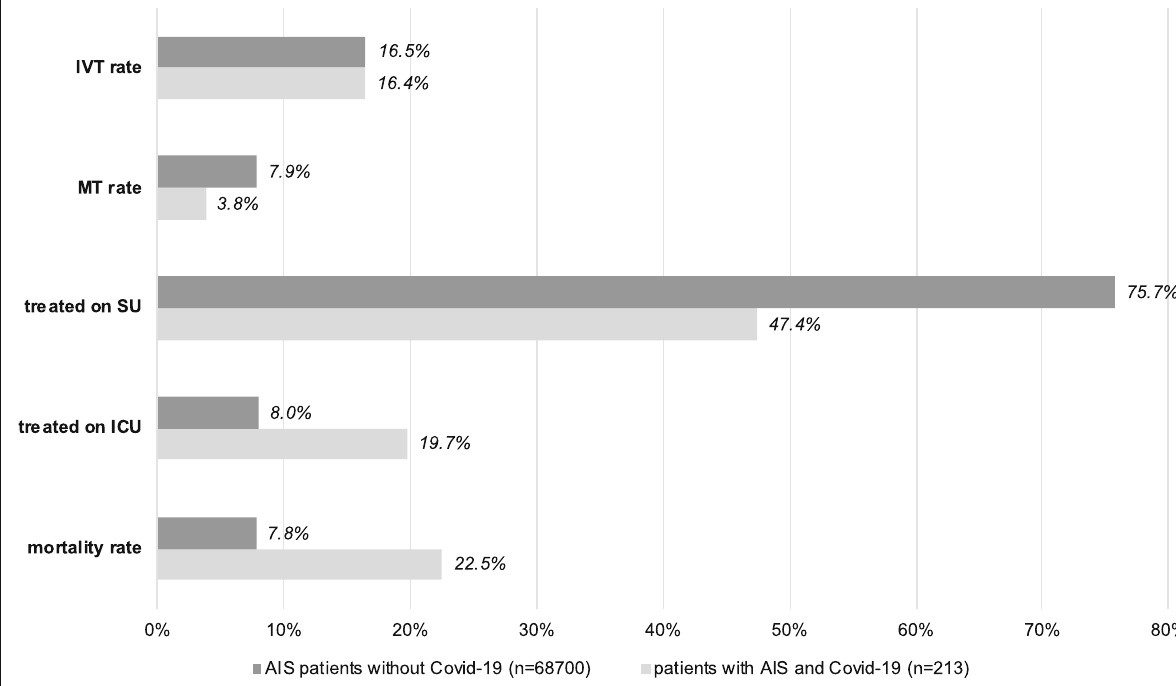
Fig. 1 Clinical Characteristics of AIS patients with and without Covid-19. Comparison of treatment rates and in-hospital mortality given in % of patients with primary diagnosis of AIS with and without concurrent Covid-19. Abbreviations: SU = stroke unit; ICU = intensive care unit; IVT = intravenous thrombolysis, MT = mechanical thrombectomy, AIS = acute ischemic stroke. * p < 0.05 ( χ